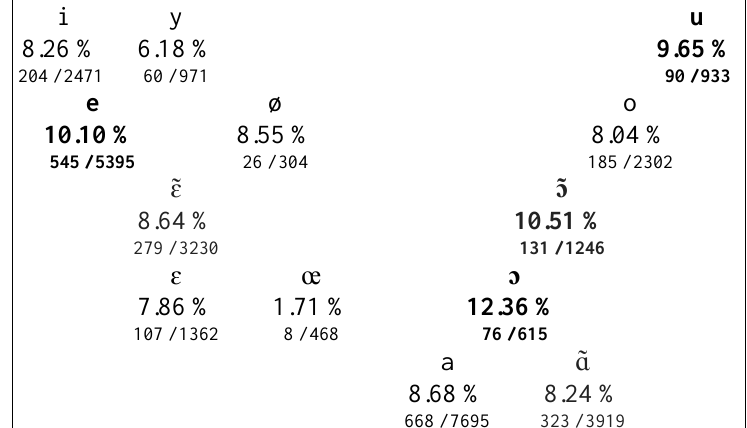
Figure 4. Vocalic space with numbers and rates of schwa realized before each vowel in all three